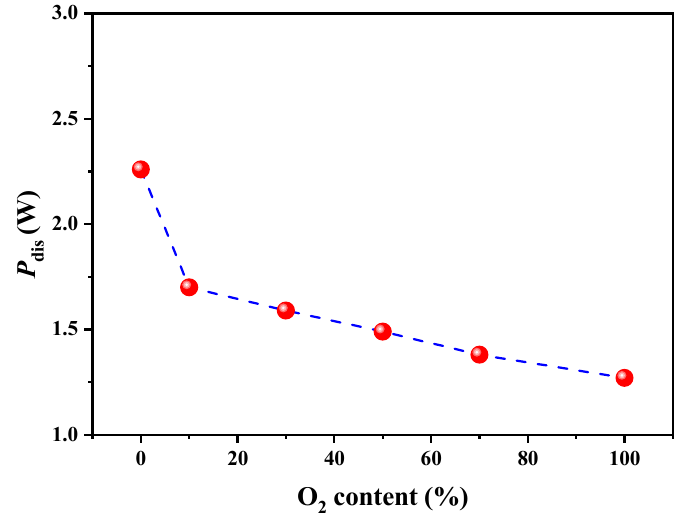
Figure 3. Effect of O 2 content in O 2 /Ar plasmas on discharge power.